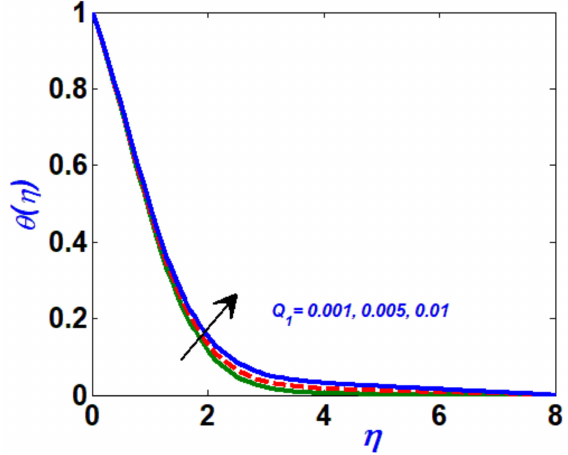
Figure 8. Temperature profile with variation in Q 1